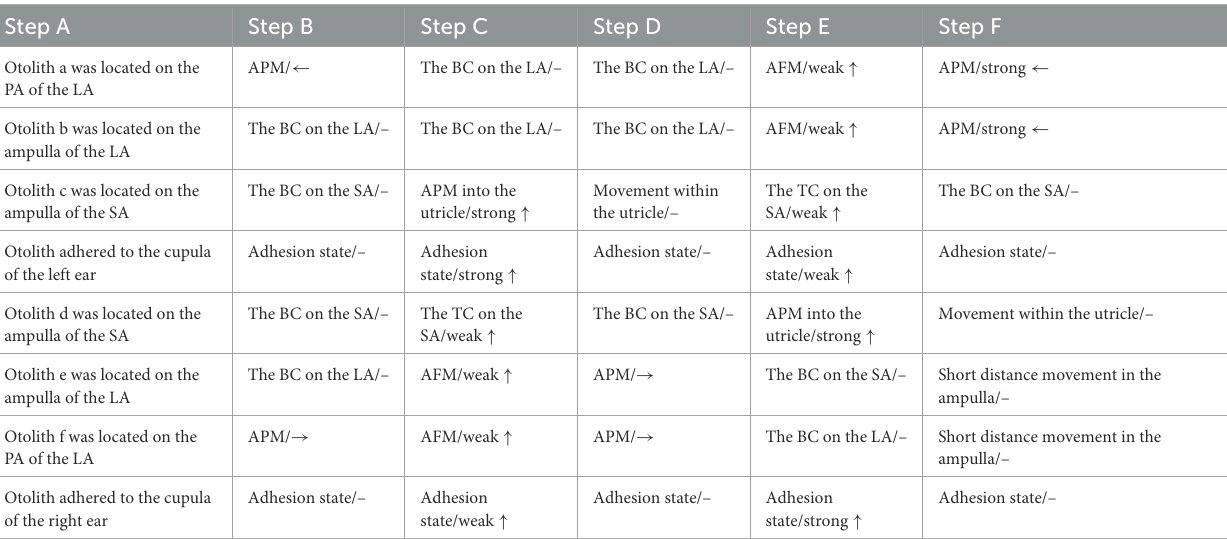
TABLE 3 Otolith motion and nystagmus speculation in the prone roll